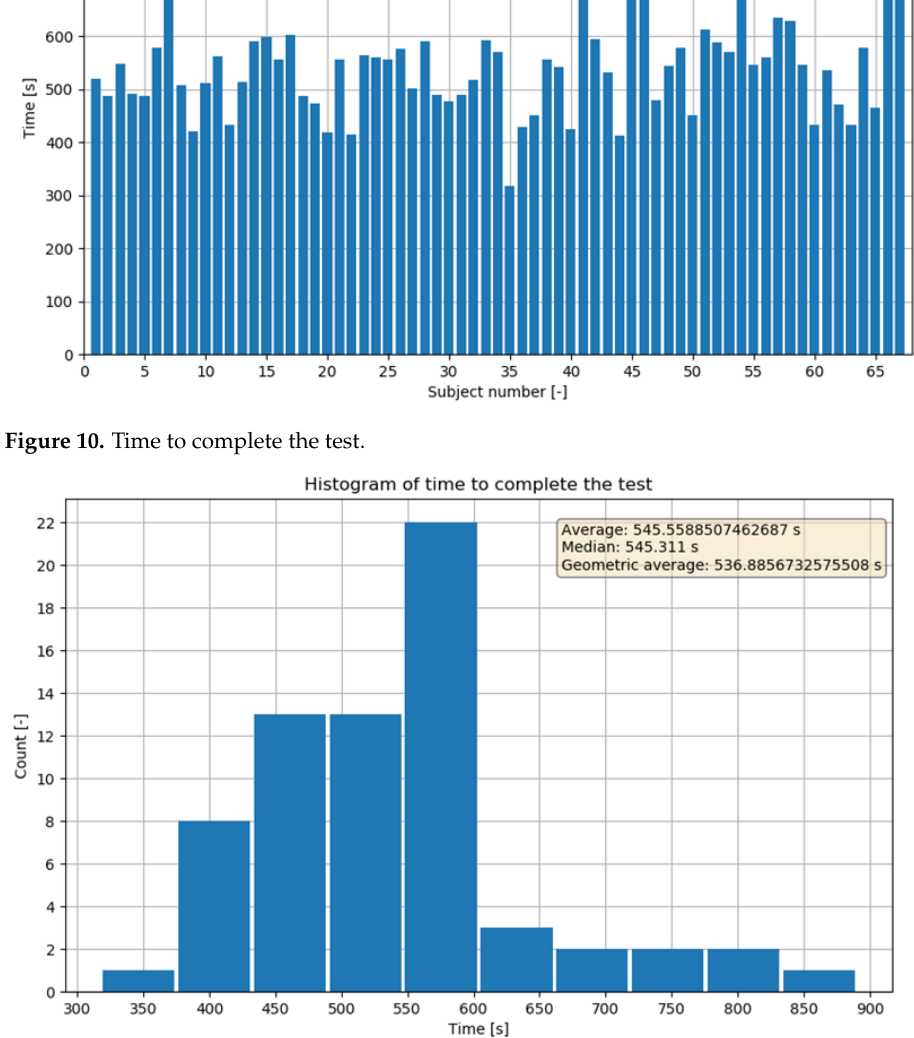
Figure 11. Histogram of time to complete the test.